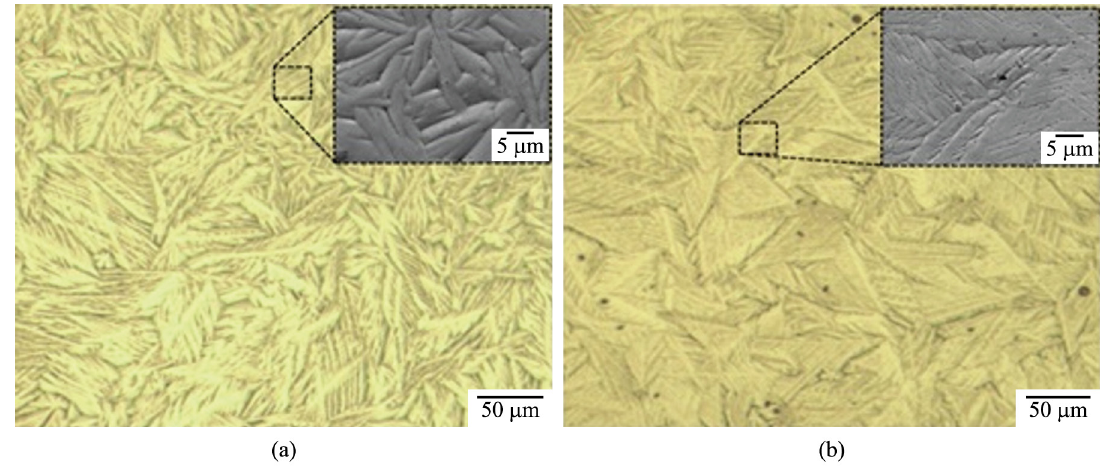
Figure 3. Optical and electronic scanning microscopy, samples: (a) HT1-24h and (b)